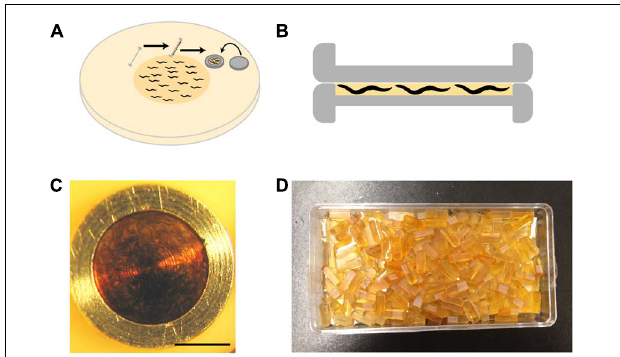
FIGURE 3 | High-pressure freezing of C. elegans . (A) To pack the carrier with worms, our preferred method is to swipe it across a densely packed lawn of worms and bacteria. After swiping, the worm-bacteria mixture is spread across the cavity of the carrier with tweezers or a worm pick (a thin platinum wire mounted to a holder), the lid put in place, and the sample immediately high-pressure frozen. The entire process takes less than 30 s. (B) A carrier when it is packed. It is filled just right, without air bubbles. The smallest cavity for freezing is used, as freezing efficiency decreases with increasing depth. (C) A carrier packed with a mixed-staged larva after high-pressure freezing, freeze substitution, and resin infiltration. This carrier has retained the “cake” of worms, but much of the time the cake floats out. One can see how densely the worms are packed by the swiping method. (D) Worms are separated from the cake and individually embedded and cured in plastic blocks. Well-packed carriers as shown in panel (C) can yield hundreds of intact worm